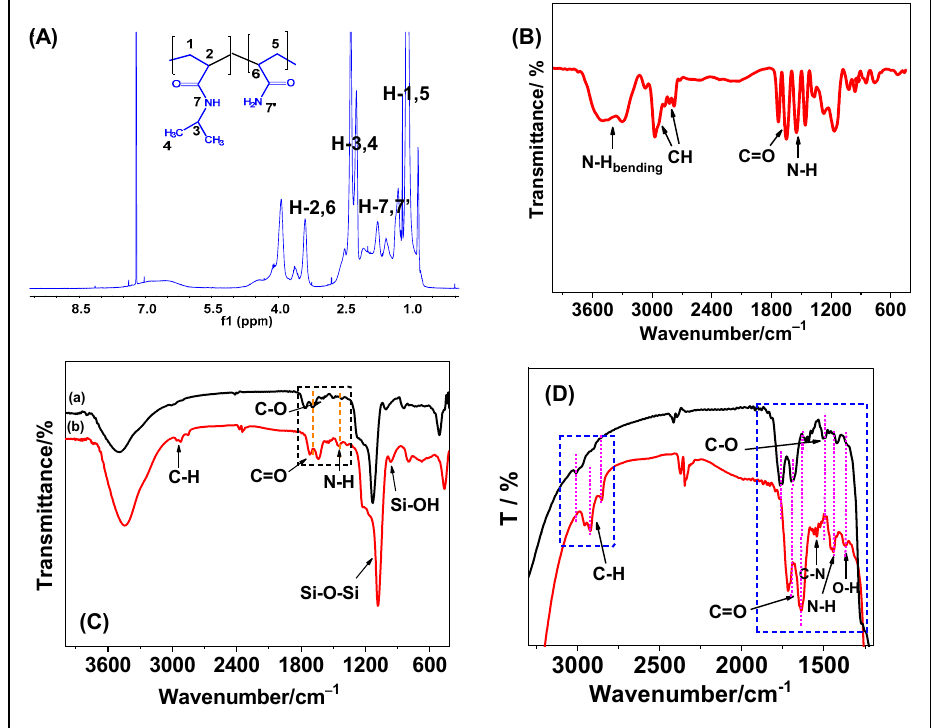
Figure 1. ( A ) 1 H NMR; ( B ) FTIR spectrum of PNIPAm-PAAm copolymer; and ( C , D ) FTIR spectra of